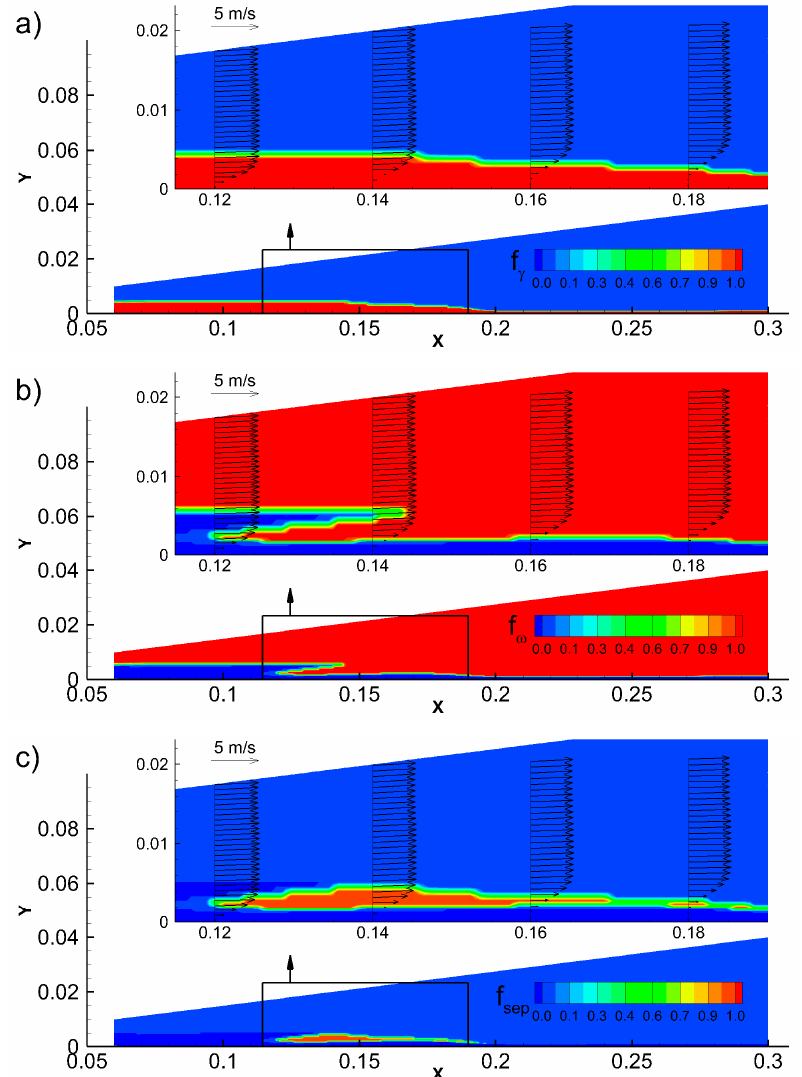
Figure 1. Flat plate case with moderately strong adverse pressure gradient and moderately high turbulence level at separation). Contour plots of ( a ) f γ -function (Equation (11)), ( b ) f ω -function (Equation (11)) and ( c ) f sep -function (Equation (10)) for simulation of separation-induced transition. The magnified views show velocity vectors along selected lines.